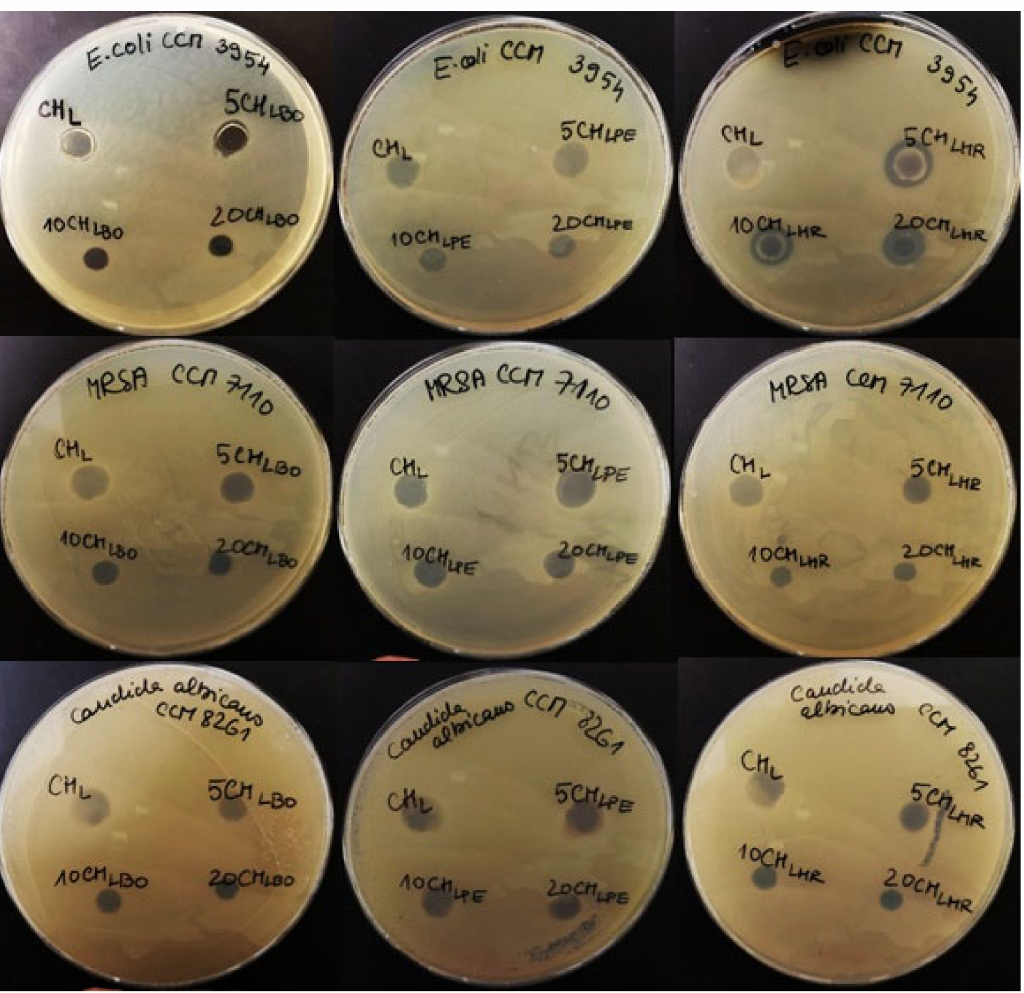
Figure 3. The results of antimicrobial activity of chitosan edible